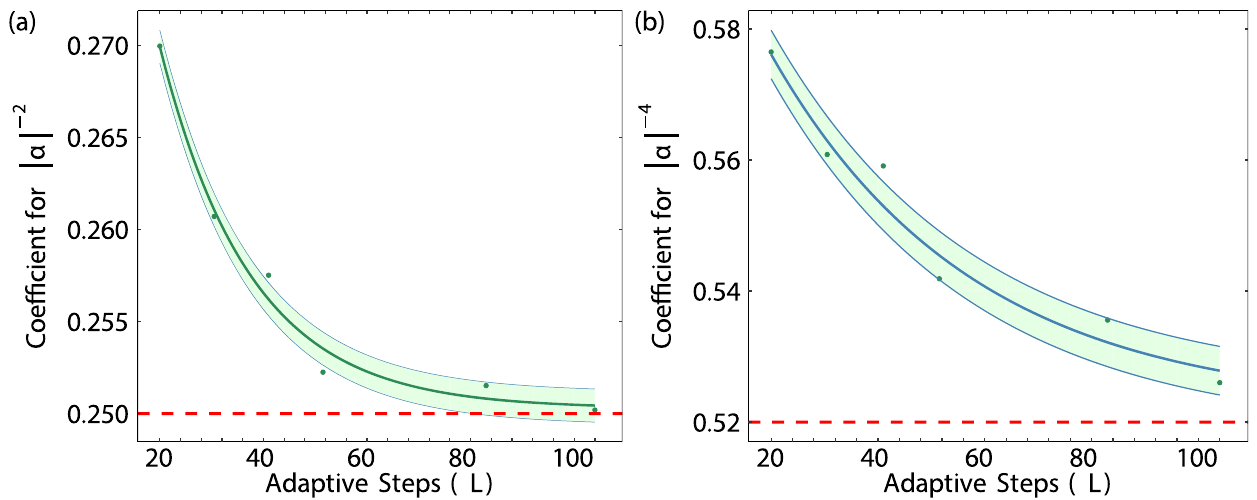
b ϕ (cid:2) , as a function of L . Note that in the limit of L → ∞ the coef fi cient